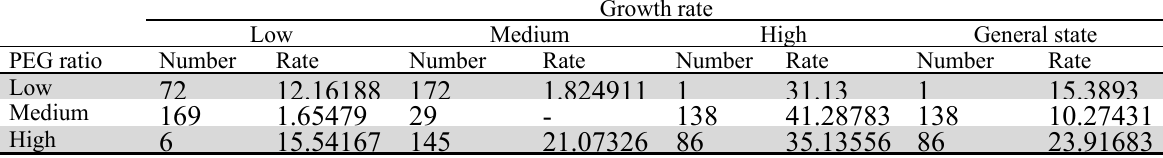
Overall ranking of firms based on PEG ratio during 5 years